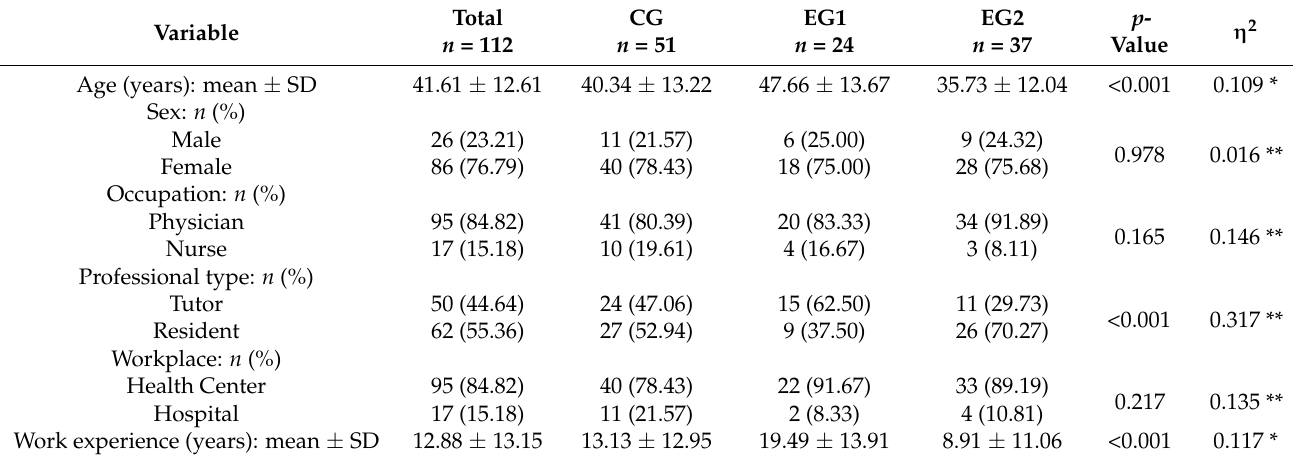
Table 1. Baseline characteristics of